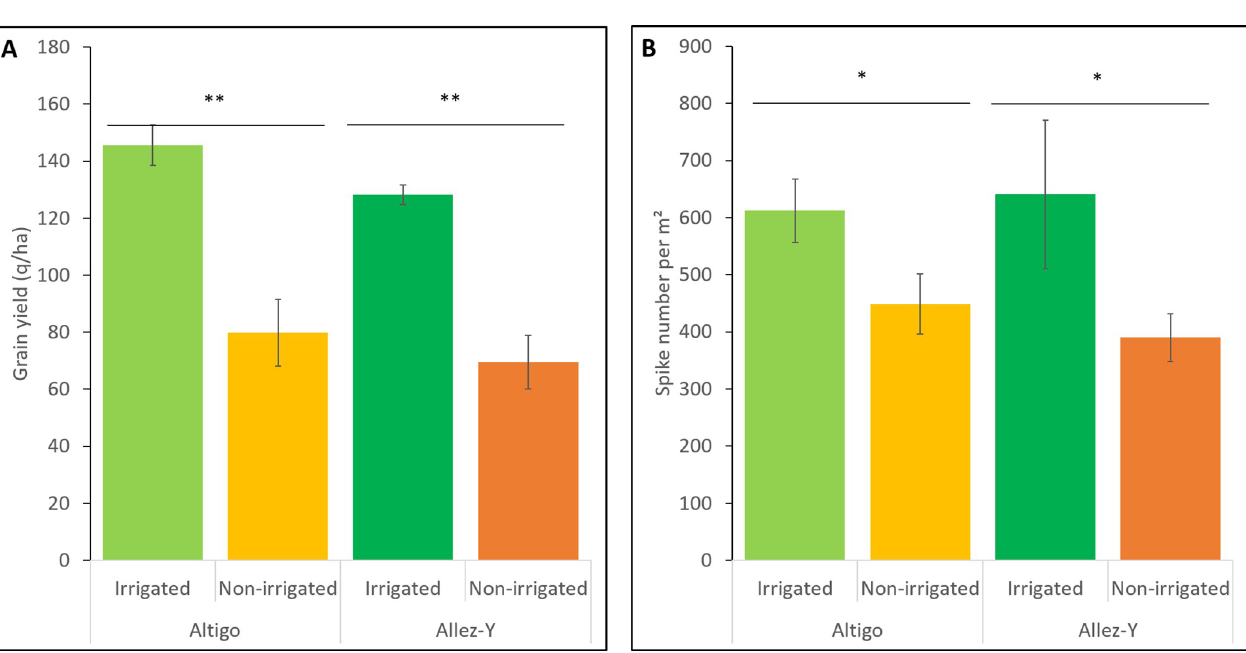
Fig 7. Drought effect on the grain yield (q/ha) (A) and spike number per m 2 (B) of two genotypes (Altigo and Allez-y). Mean values and standard deviation were obtained from three replicates (Student’s T test, � indicates a P < 0.05 and �� indicates a P <